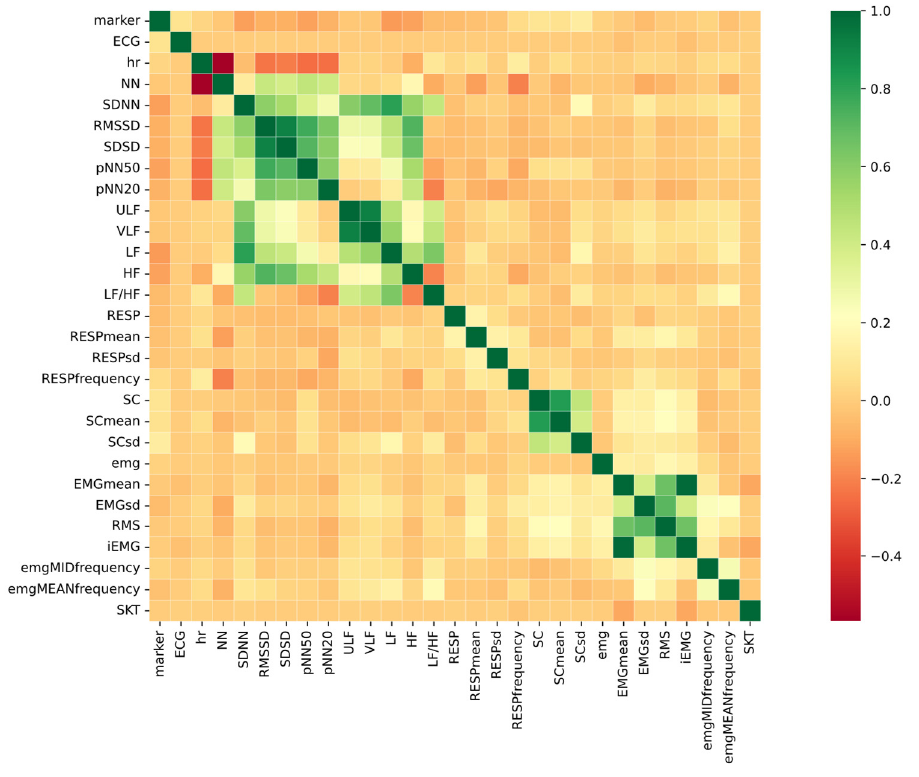
Figure 3. Pearson correlation analysis. Table 6. The performance of several classification